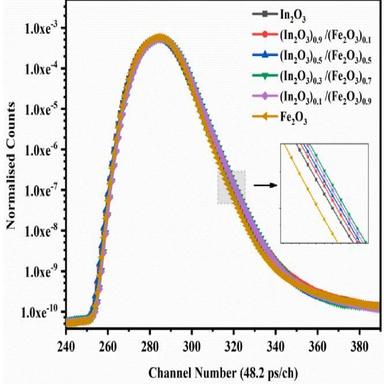
Lifetime spectra of In2O3, Fe2O3, and their In2O3–Fe2O3 n-n type NCs, inset: zoom view of the selected area.